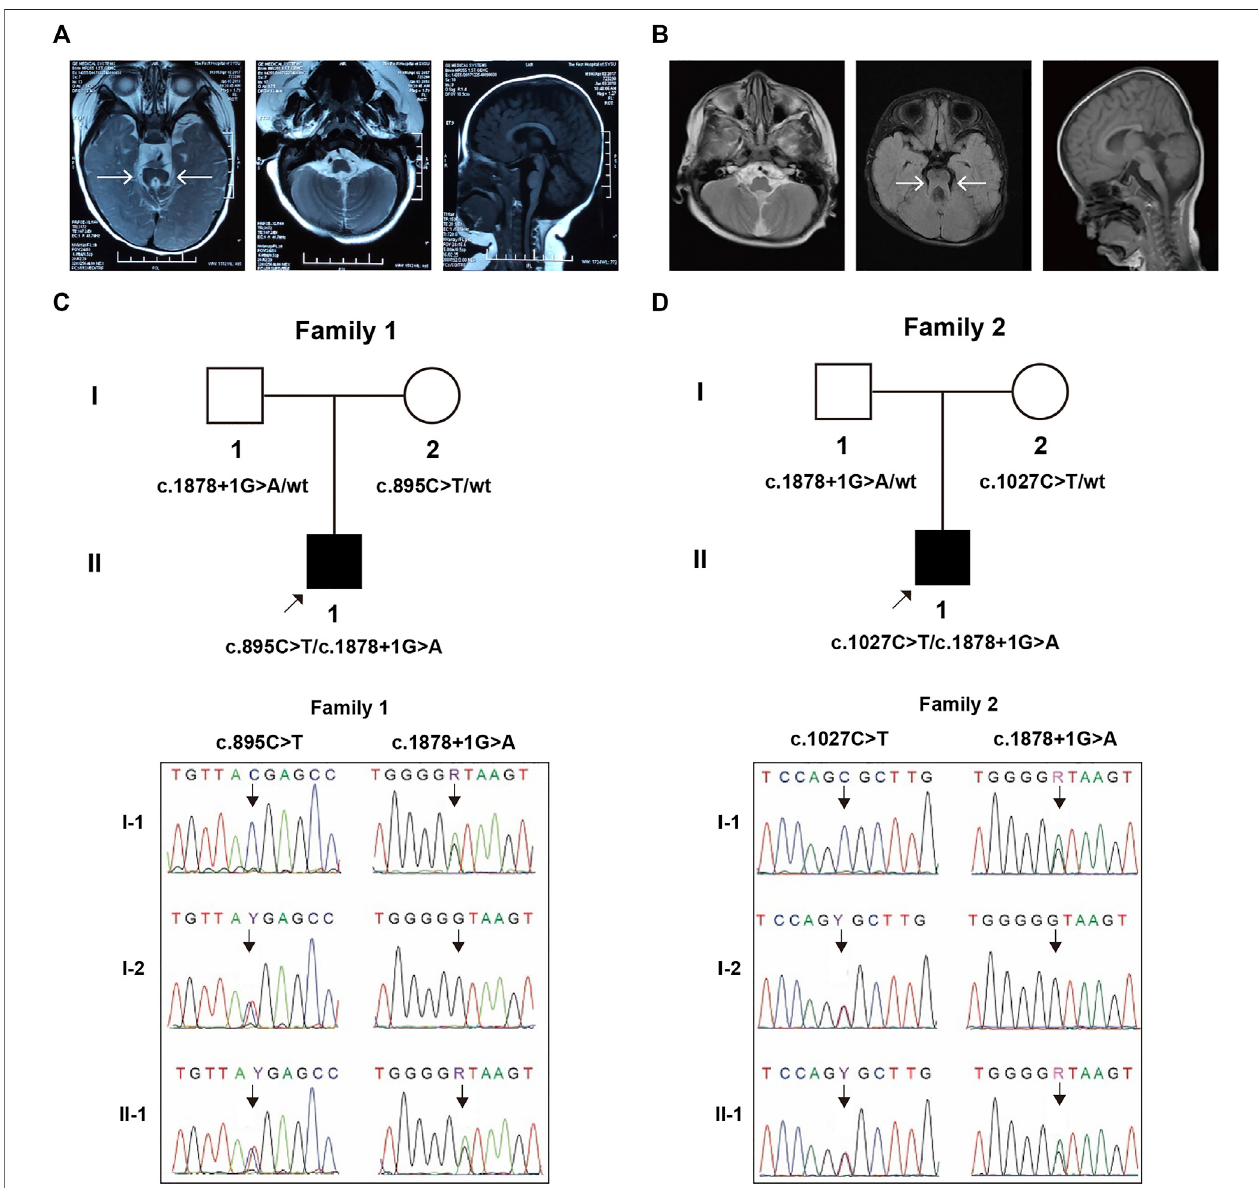
FIGURE 1 | MRI imaging and genetic segregation of variants within trios. The isthmus is abnormally thickened and lengthened, forming a molar-like structure between the superior cerebellar peduncle and the dysplastic cerebellum vermis in Patient 1 (A) and Patient 2 (B) . The segregation con fi rmation in family 1 (C) and family 2 (D)